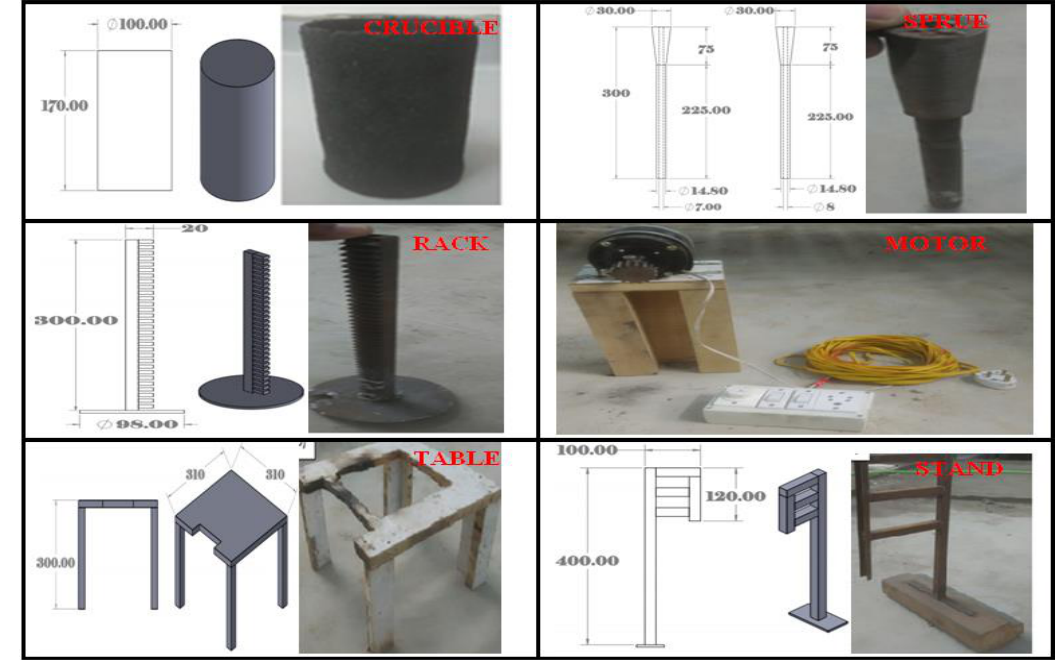
Figure 2. Components used in designing the experimental set up, crucible, sprue, rack and pinion, induction motor, table for height adjustment and bracket for supporting